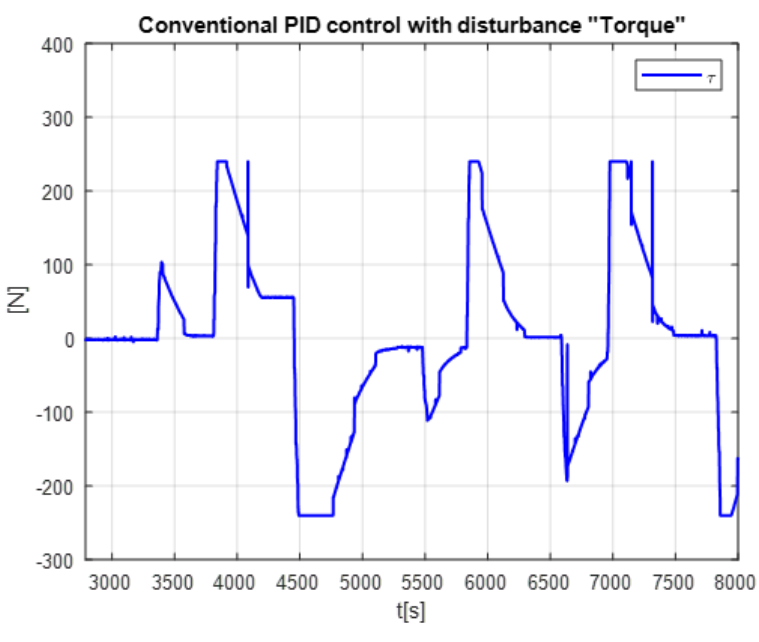
Figure 16. Disturbance free self tuning PID